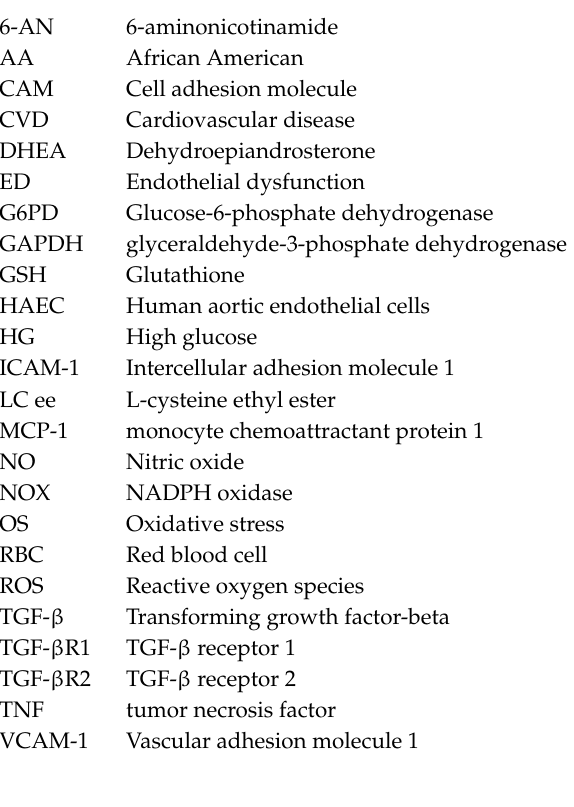
analysis. Supplementary Table S2. List of antibodies and dilutions used for Western blot analysis. Figure S1. (A–I) The e ff ect of metabolic insults created by treatment with high glucose (HG; 25 mM) or palmitate (200 µ M) on G6PD, TGF- β 1, TGF- β 1 receptors, and NADPH oxidases (NOX) in human aortic endothelial cells (HAEC) and monocyte-endothelial cell adhesion. Figure S2. (A–H) The e ff ect of L-cysteine ethyl ester (LC ee) on TGF- β / NOX in H2O2-treated HAEC and monocyte-endothelial cell